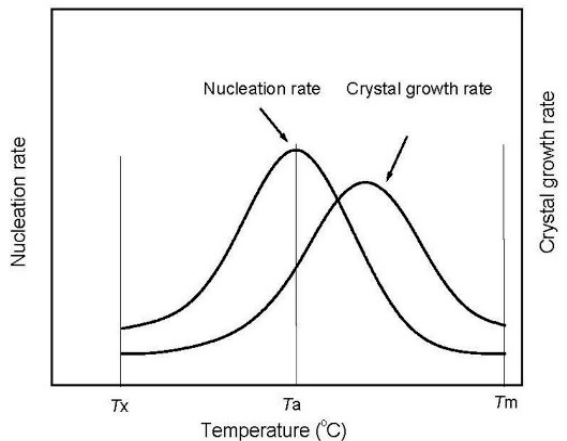
Figure 6. Schematic diagram showing the plots of nucleation rate and grain growth rate as a function of annealing temperature.